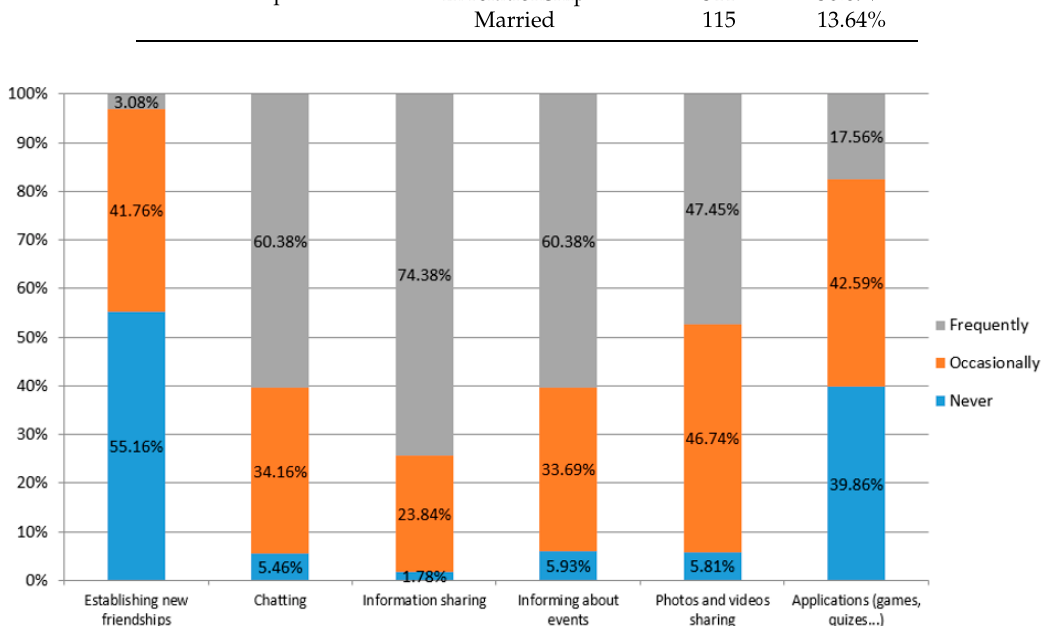
Figure 1. Frequency of online social networks (OSN) activities.